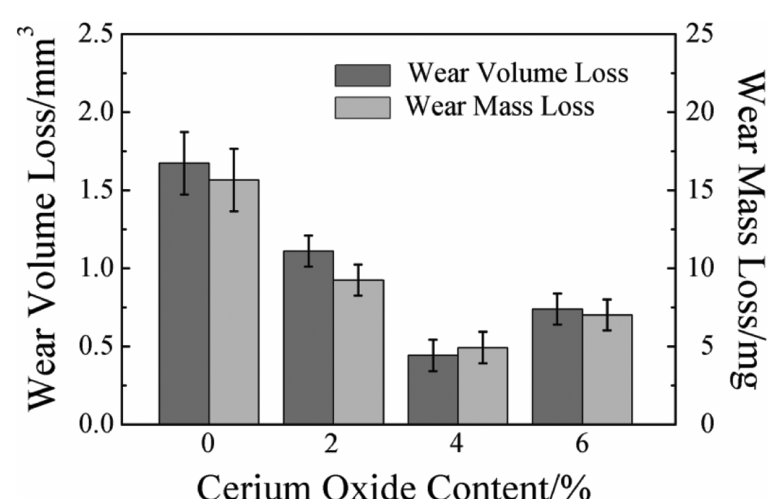
Figure 10: Wear losses of the composite